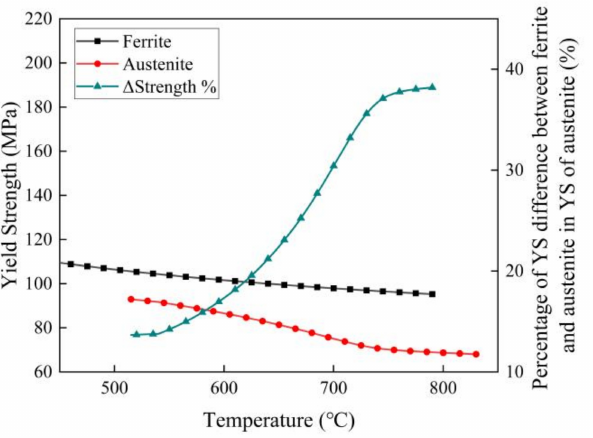
Figure 6. The yield strength of austenite and ferrite and strength difference of two phases versus